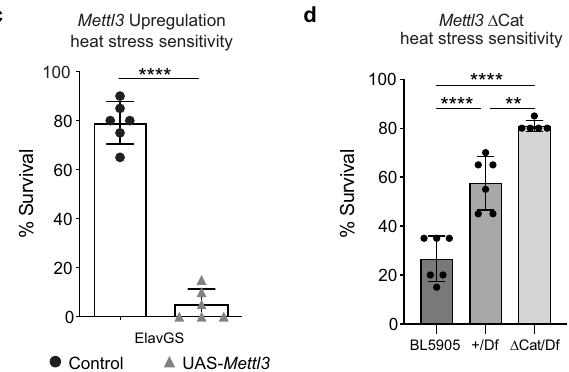
in each vial Fig.2| Mettl3 knockdownanimalsareresilienttoheatstress.a SchematicofHS survival after 24h recovery. UAS-Mettl3 fl ies were severely stress-sensitive, and HS stressassay.Fliesare6-day-old.Fliesareputonto RU486food ifneeded toturnon timewasreducedto1htohaveatleast5 – 10%ofthe fl iessurviving.Eachdatapoint theexpressionoftheRNAitransgenefor6days.FliesareHSat38.5°Candallowed represents percent survival in vials of 20 fl ies per replicate. Data presented as to recover overnight in normal food or RU486 food at 25°C. Percent survival in mean±SD, **** p <0.0001, Student ’ s two-tailed t -test, p <0.0001. d Catalytic Mettl3 each vial of 20 animals are scored after 24h. b Ubiquitous knockdown of Mettl3 Mutant( Δ Cat/Df)vs Mettl3 de fi ciency(Df/+)vs w 1118 (BL5905)(+/+)wereHSfor1.5h at 38.5°C and scored for survival after 24h recovery. Each data point represents (DaGal4, DaGS),Neuron-speci fi cknockdown(ElavGS),and corresponding controls percent survival in vials of 20 fl ies per replicate. Data presented as mean±SD, (mCherry RNAi) were HS for 1.5h at 38.5°C and scored for survival after 24h ** p <0.01, **** p <0.0001, One-way ANOVA with Tukey ’ s test. p <0.0001, recovery. n =7biologicalreplicates,eachdatapointrepresentspercentsurvivalina vialof20 fl iesperreplicate.Datapresentedasmean±SD,** p <0.01,**** p <0.0001, p <0.0001, p =0.0014.SourcedataandstatisticalanalysisareprovidedasaSource Data fi Student ’ s two-tailed t -test. p =0.0011, p <0.0001, p <0.0001. c Neuron-speci fi c (ElavGS)upregulationof Mettl3 andcontrolwereHSfor1hat38.5°Candscoredfor